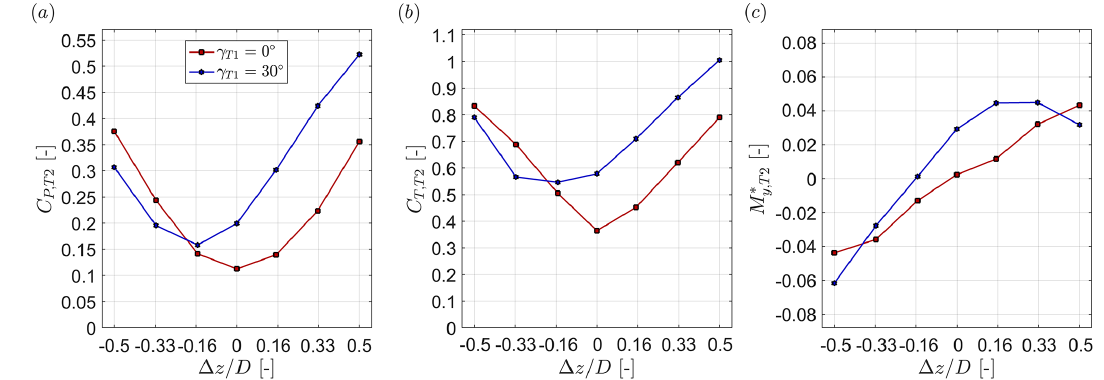
Figure 8. Downstream turbine (a) power coefficient, (b) thrust coefficient and (c) normalized yaw moment as a function of its lateral offset position (cid:49)z/D . The downstream turbine yaw angle is kept constant at γ T2 = 0 ◦ . The downstream turbine T2 is located at x/D = 3. The turbines are exposed to inflow B.